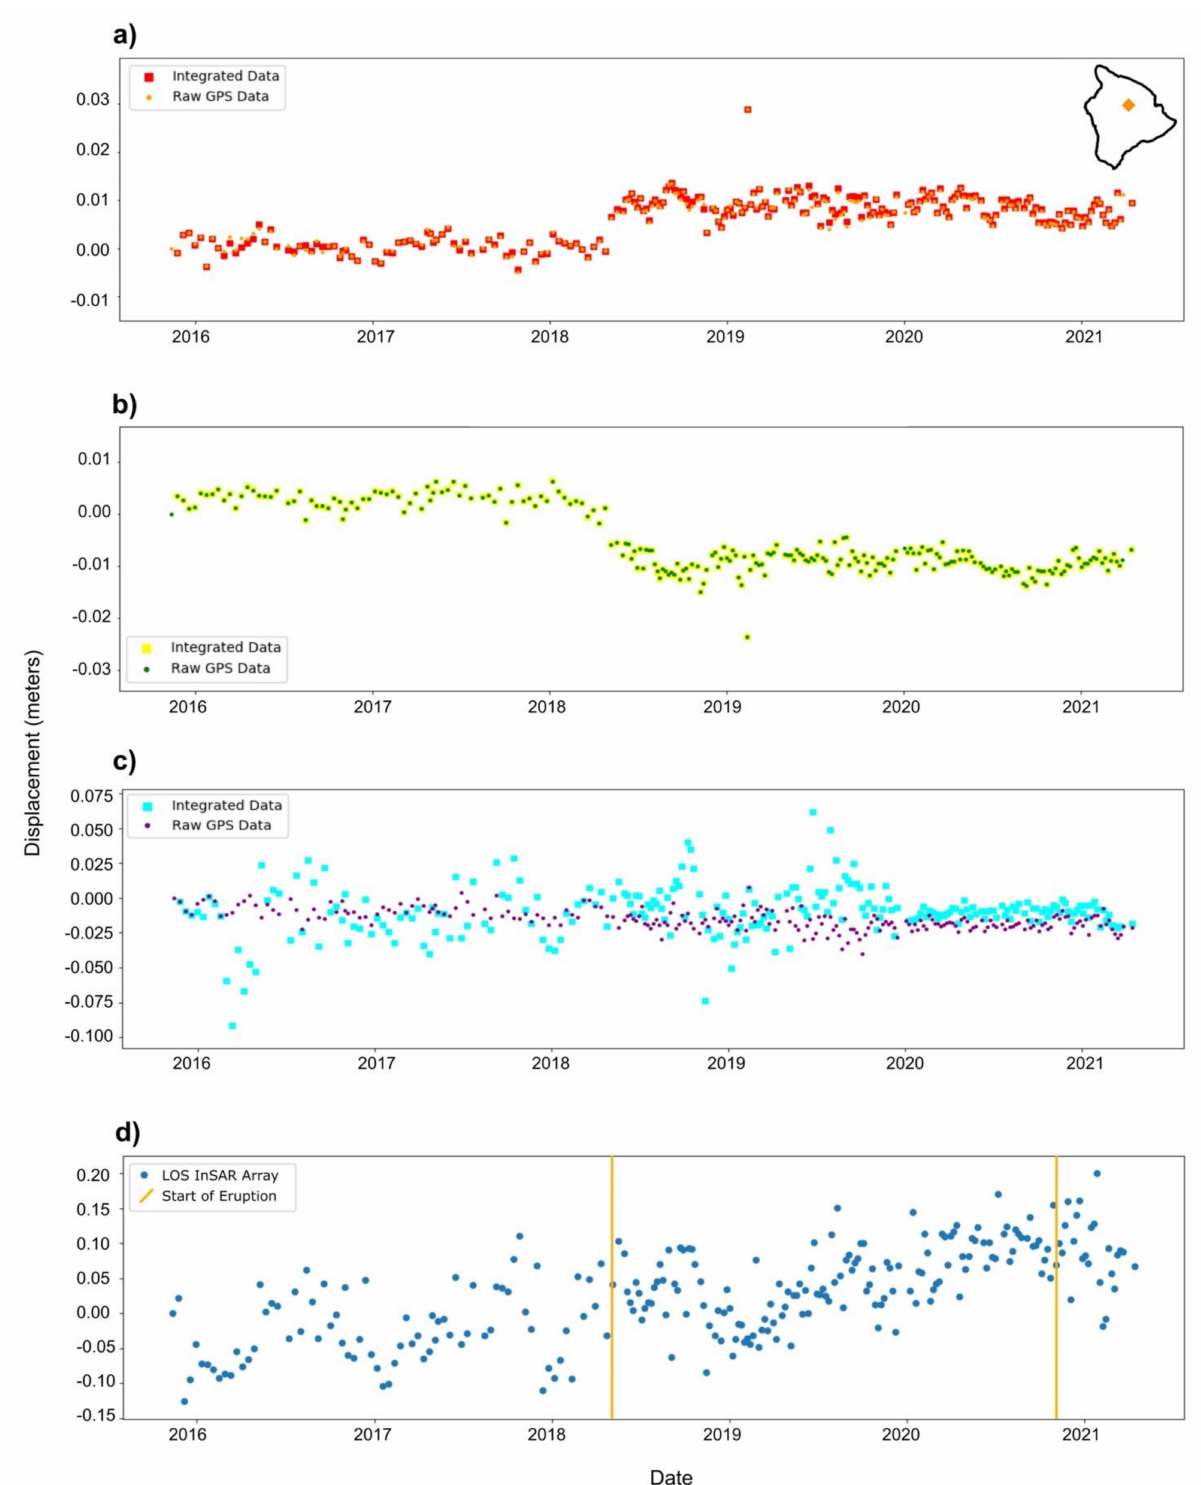
Figure 10. Integrated results compared to original, raw GNSS time series in the ( a ) east-, ( b ) north-, and ( c ) up-components of motion at MKEA GNSS station (19.801 ◦ N, –155.456 ◦ W). Motion in the east- west and north-south directions are slightly more constrained, while motion in the up-down direction is significantly transformed after combining the DInSAR and GNSS datasets together. ( d ) DInSAR LOS time series at the same pixel, MKEA station. Yellow lines are as in Figure 8, above. The inset in subfigure a shows location of MKEA station in